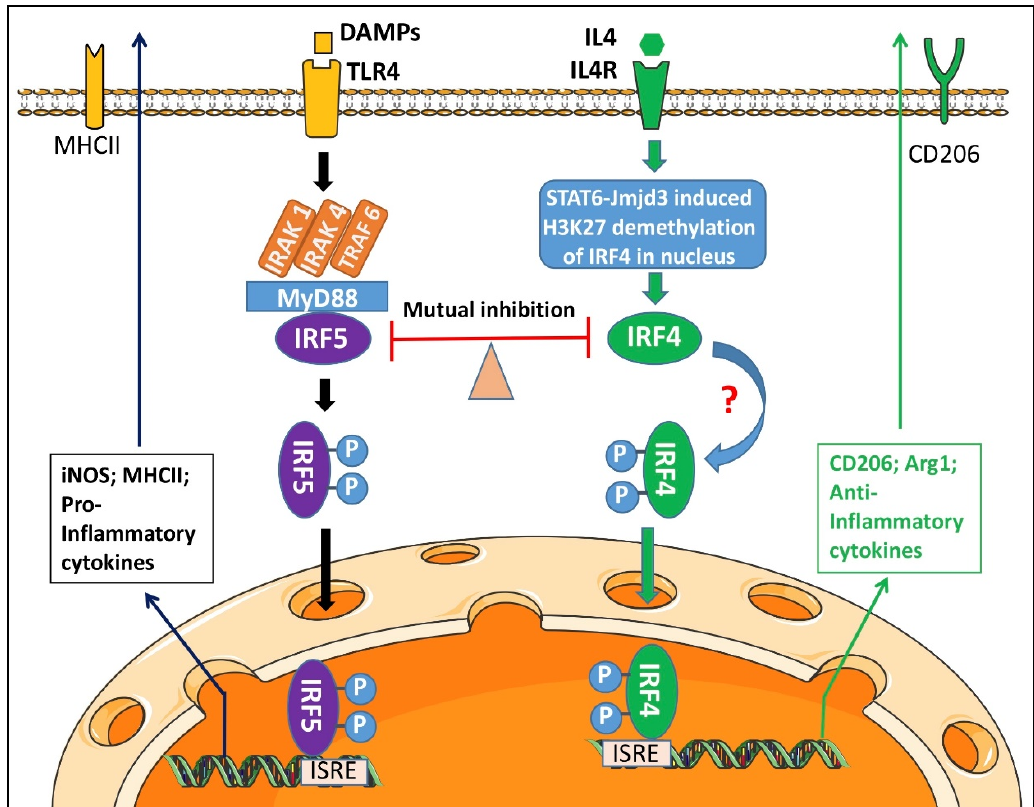
Figure 6. Mechanistic diagram for microglial IRF5/4 activation. Upon DAMPs’ Stimulation, a Myddosome is formed in the cytoplasm to phosphorylate IRF5. P-IRF5 then translocates into the nucleus and bind to ISRE to regulate the expression of pro-inflammatory mediators. IL4 signaling, however, triggers activation of STAT6-Jmjd3-IRF4 pathway. IRF4 competes with IRF5 for MyD88 binding and the IRF5-IRF4 regulatory axis regulates microglial activation in a balanced